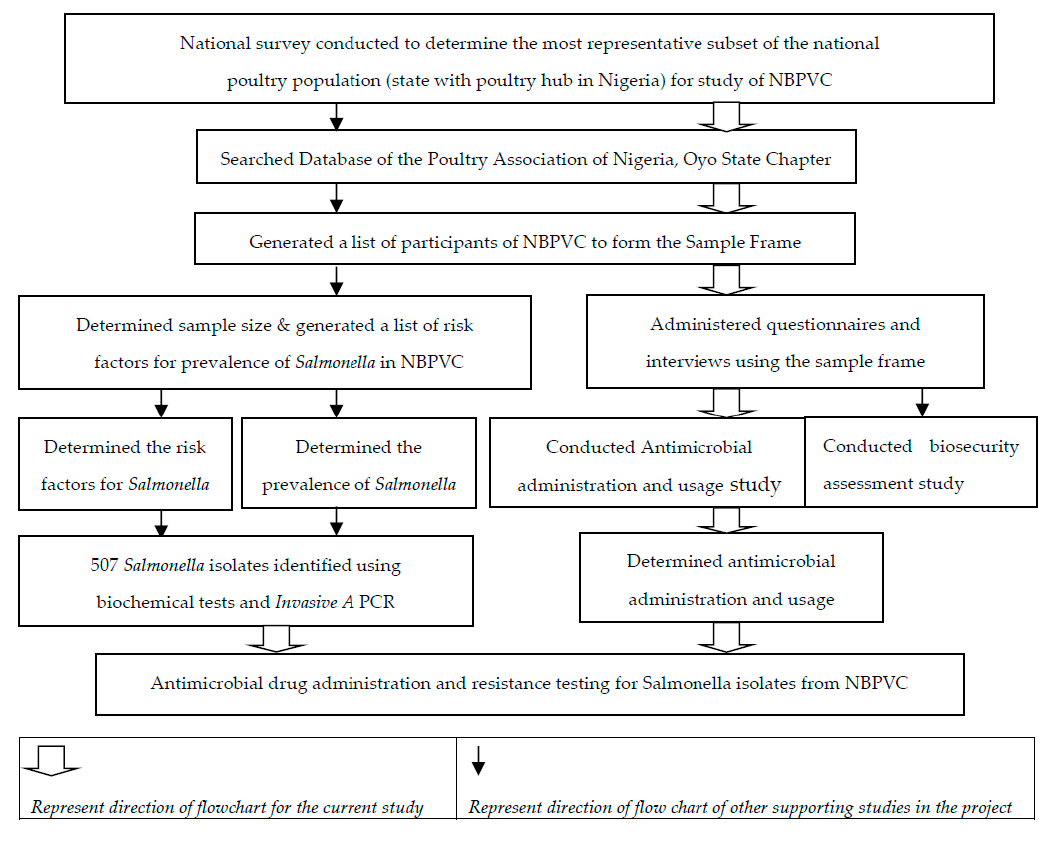
Figure 1. Schematic diagram of the study of antimicrobial susceptibility testing of Salmonella isolates and antimicrobial drug administration in the broiler production value chain in Nigeria (NBPVC). Table 1. Demography of antimicrobial resistance profiling of Salmonella spp. at the production stages along the broiler value chain in Nigeria.